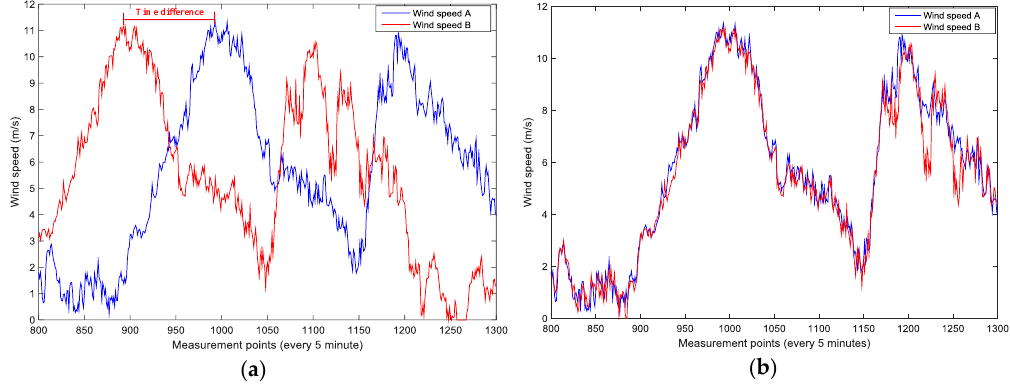
Figure 5. Wind speeds series in time of wind turbine A and B in a certain period: ( a ) before shifting the time difference; ( b ) after shifting the time difference.